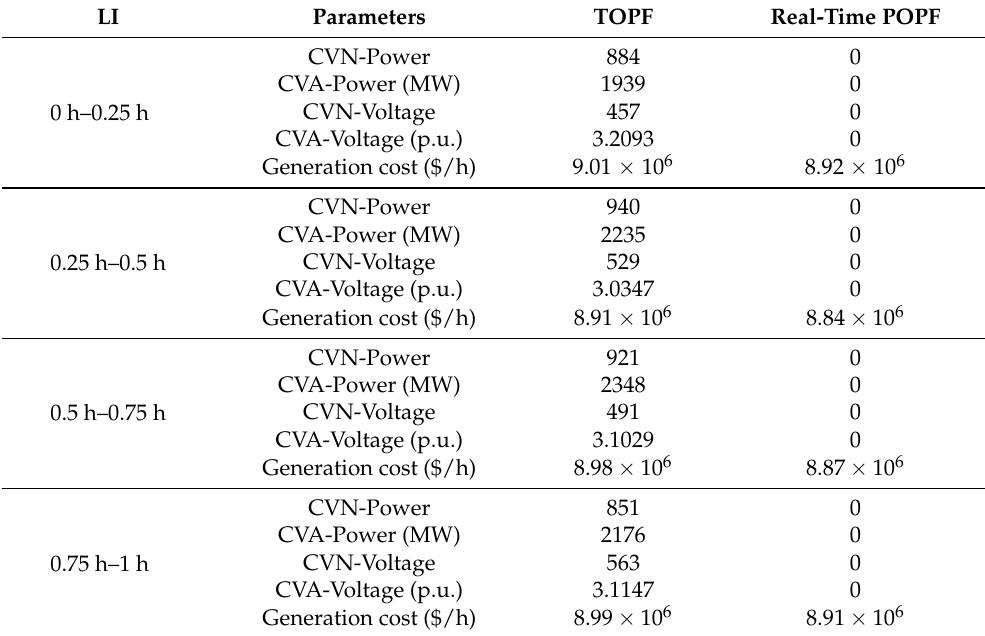
Table 1. Comparisons Between traditional optimal power flow and Real-time period optimal power